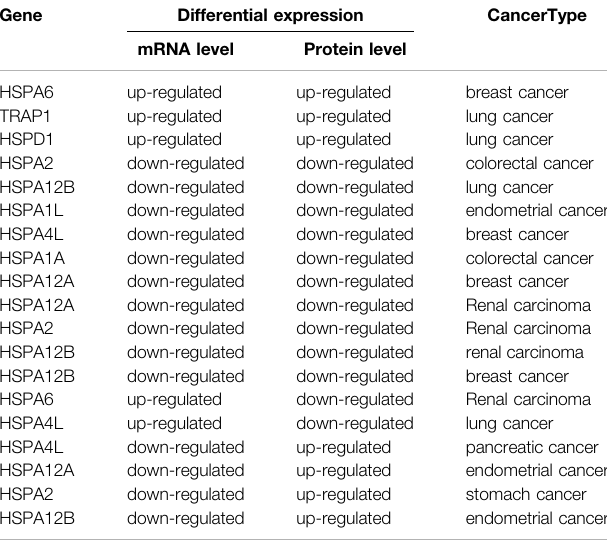
TABLE 2 | The correlation of HSPs between mRNA and protein expression pattern.